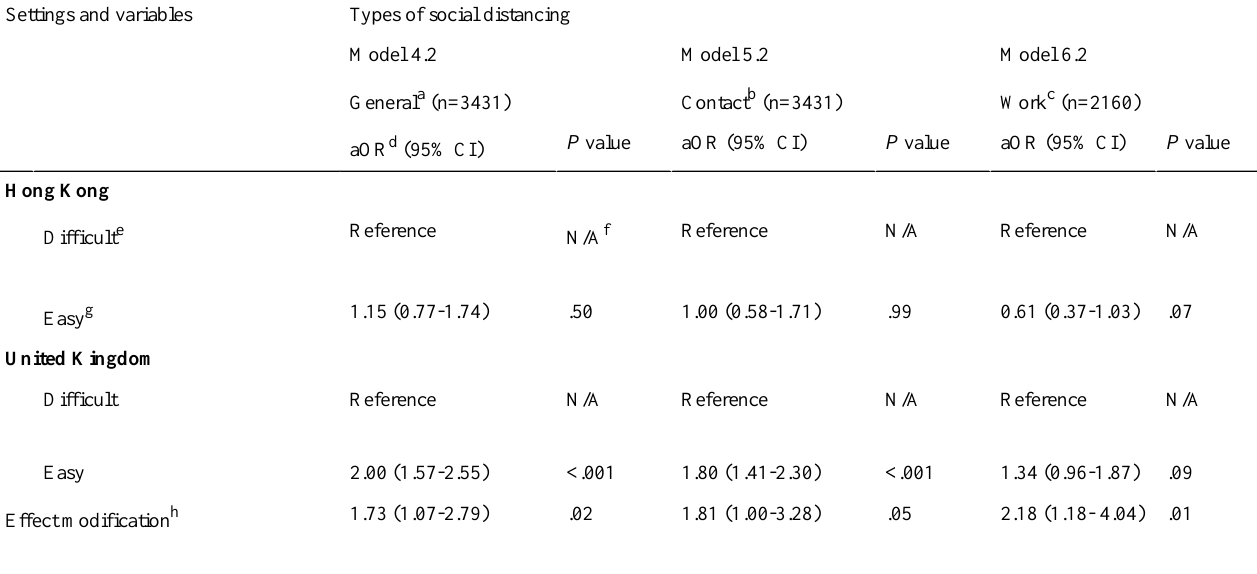
Table 5. Setting-specific effects and effect modification (by setting) of perceived ease of transmission on the adoption of social distancing measures. The models have been adjusted for all